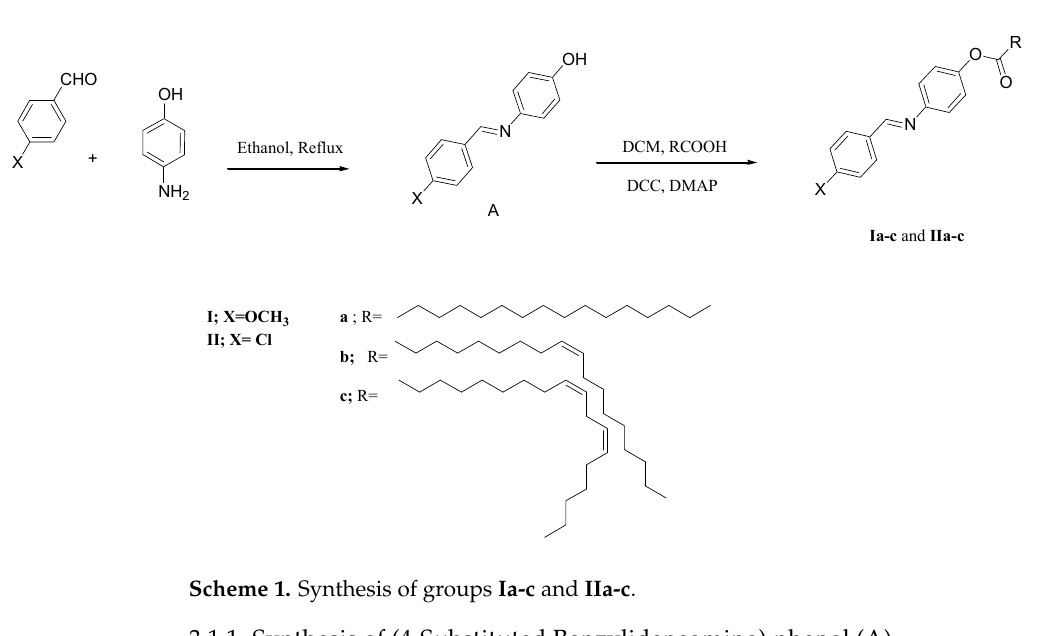
Figure 10. ( a ) Steady-state photoluminescence and ( b ) time-resolved fluorescence spectra of liquid crystalline